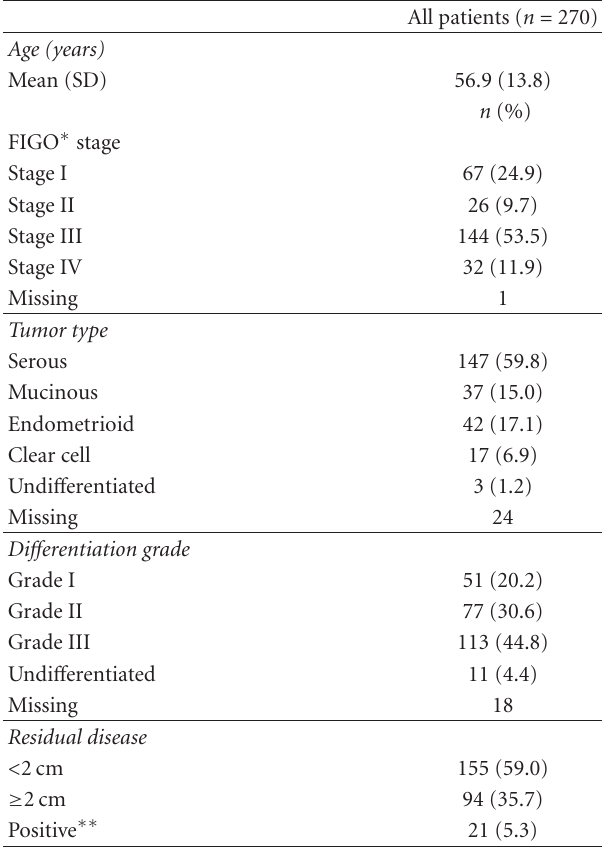
∗ FIGO: International Federation of Gynecology and Obstetrics. ∗∗ Amount